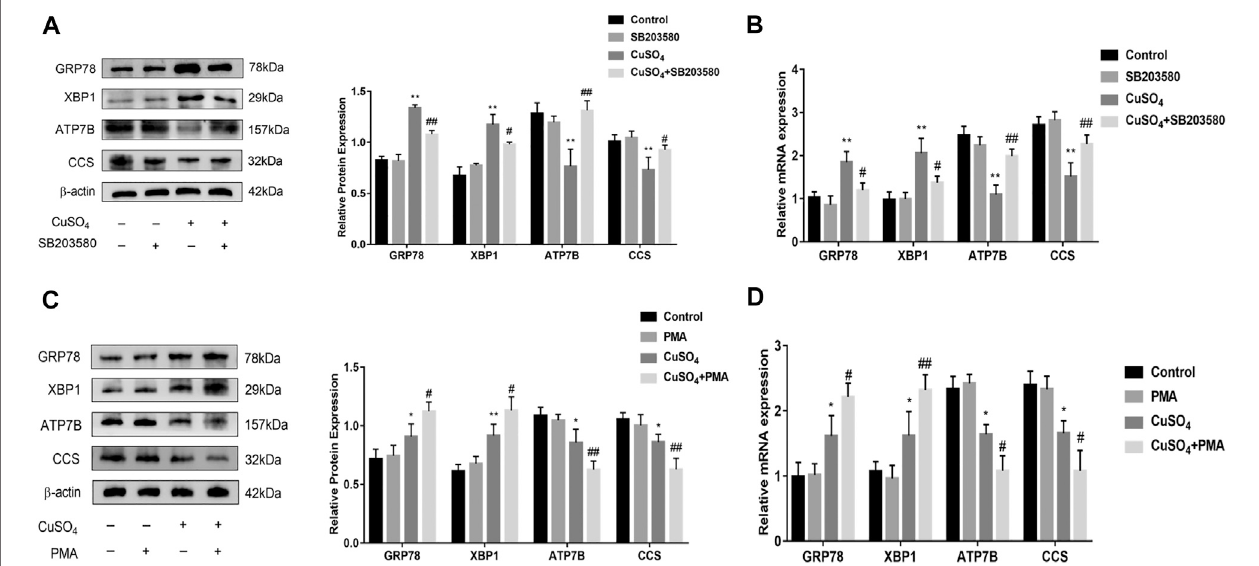
FIGURE 6 | Inhibition and activation of the P38MAPK pathway regulates endoplasmic reticulum stress and copper transport ( A ) Western Blot detects the protein expression of GRP78, XBP1, copper transporter ATP7B, CCS after treatment with the P38MAPK pathway inhibitor SB203580; ( B ) The mRNA levels of GRP78, XBP1, ATP7B,CCSincellstreatedwiththeSB203580( C )Westernblottinganalysisanddensitometricquanti fi cationofGRP78,XBP1,ATP7B,andCCSproteinlevelsinHSCs treated with the P38MAPK pathway agonists dehydrocorydaline; ( D ) mRNA levels of GRP78, XBP1, ATP7B, and CCS in HSCs treated with dehydrocorydaline. The data are expressed as the mean ± SEM ( n (cid:2) 4). * p < 0.05, ** p < 0.01 vs. Control group; # p < 0.05, ## p < 0.01 vs. CuSO 4 group.